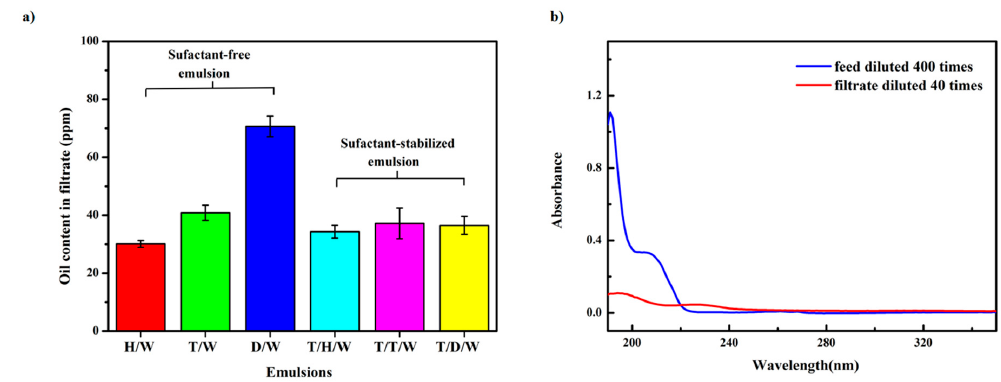
Figure 7. Oil-in water emulsion separation results of the CSPNM. ( a ) Oil content in the filtrates for a series of emulsions; ( b ) UV–Vis spectra for the T/W (toluene-in-water) emulsion diluted 400 times and the filtrate diluted 40 times.